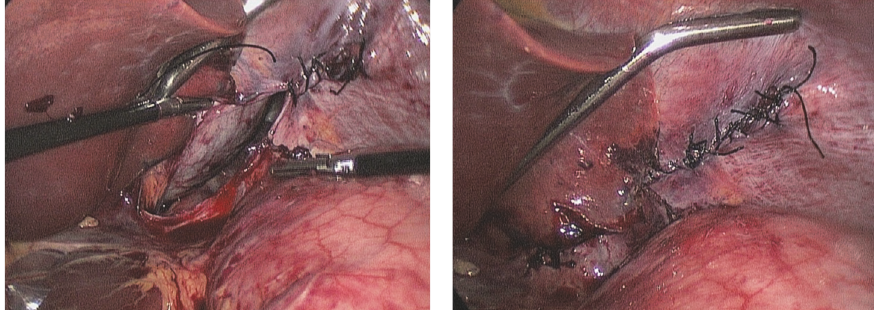
Figure 6: Laparoscopic view showing repair of the diaphragmatic